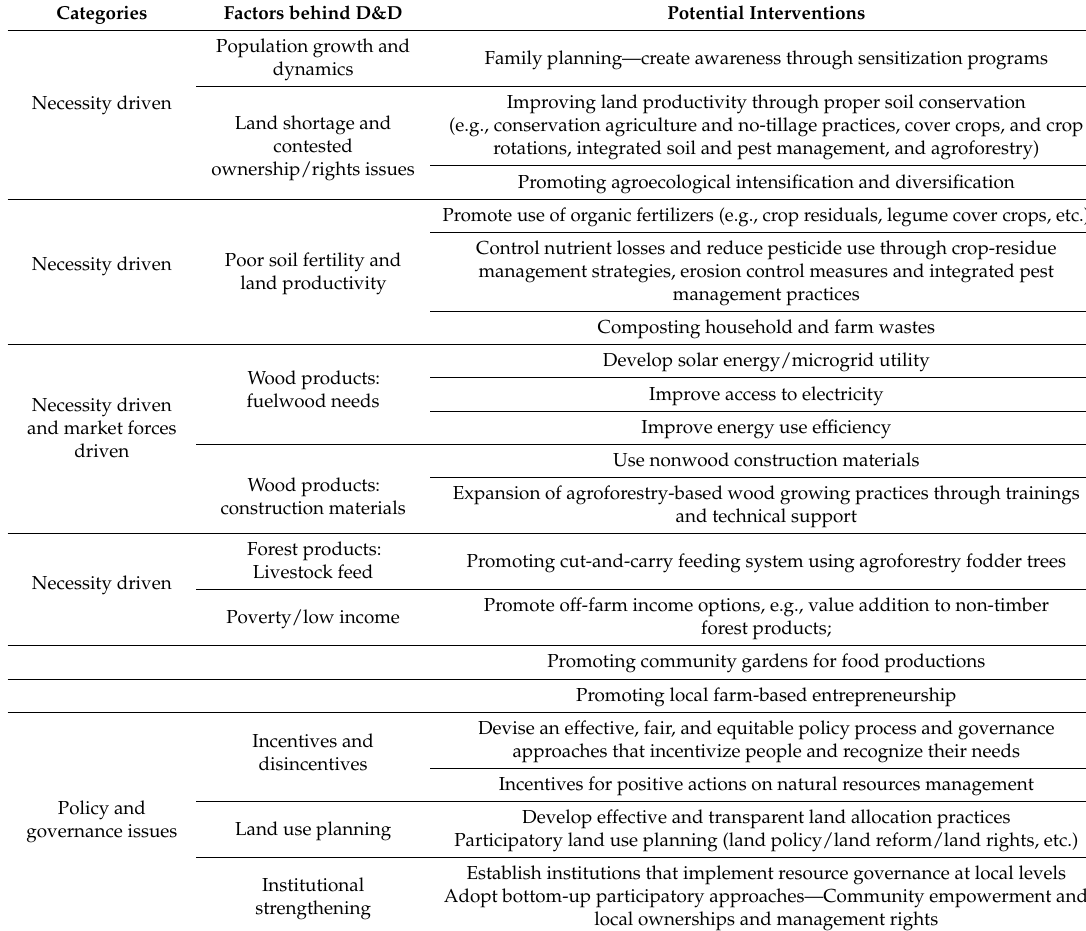
Table 2. Structural strategies that may be used to address factors aggravating